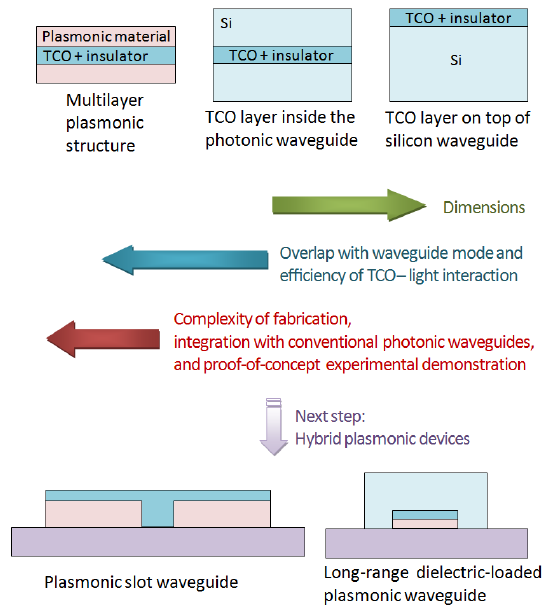
Figure 17: Suggested modulators designs are varied by compact- ness and ease of integration with low-loss waveguide (arrows show direction of more profound influence). Plasmonic multilayer